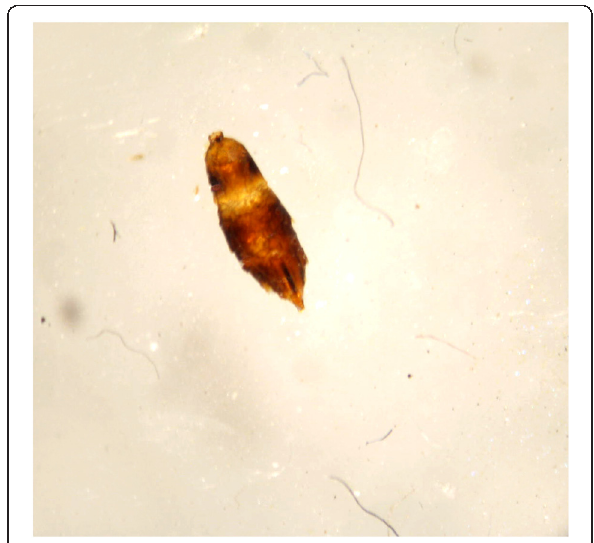
Figure 2 Dorsal view of the abdomen of Sclerodermus sp. by stereoscope. Abdominal segments are partially